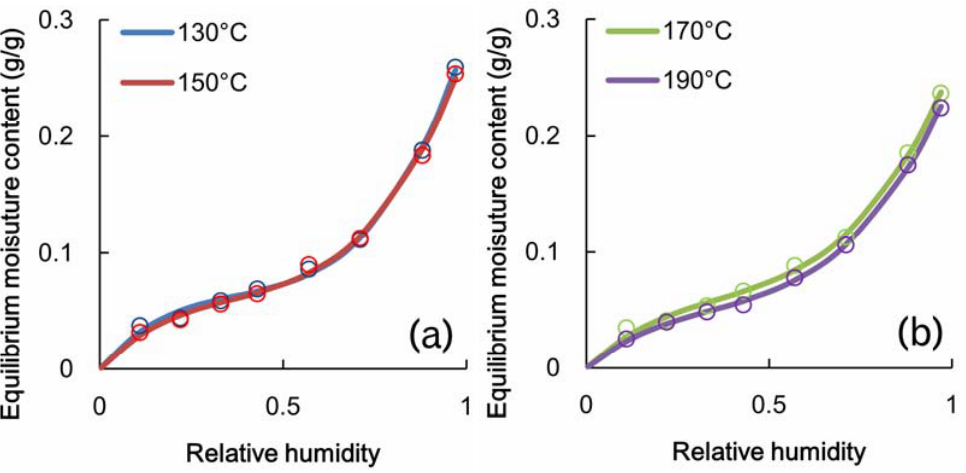
Figure 5. Adsorption isotherm of heated poplar veneer.